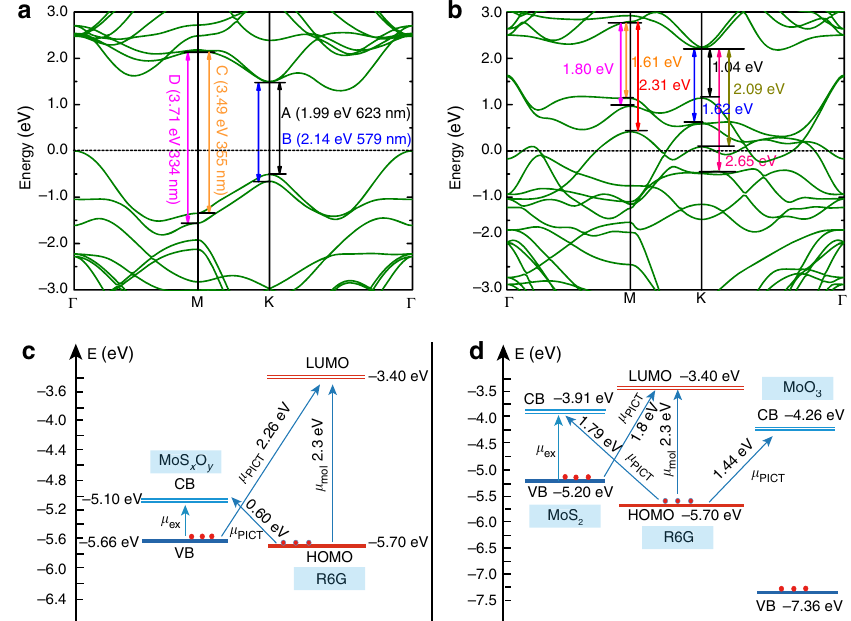
Fig. 6 Energy-level diagrams illustrating the electronic transitions. The calculated band structures of MoS 2 a and MoS x O y b taking Fermi level as reference. Schematic energy-level diagrams of R6G on c MoS x O y and d MoS 2 and MoO 3 with respect to the vacuum level NATURE COMMUNICATIONS | 8: